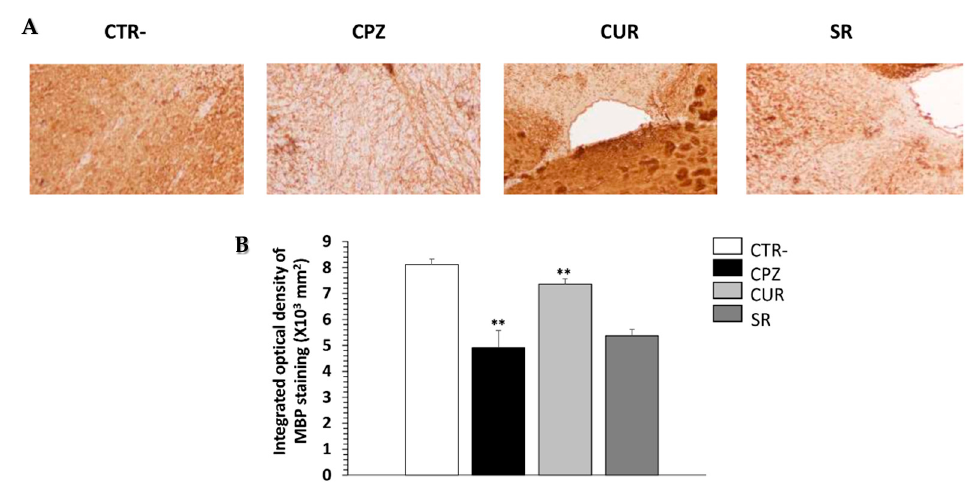
Figure 8. Effect of curcumin treatment on myelin content of corpus callosum during cuprizone intake. ( A ) Representative images for myelin basic protein (MBP) staining results (Obj × 20). ( B ) Quantitative analysis of MBP expression. n = 10 brain-sections from three mice, per experimental group. Negative group (CTR-), cuprizone-mice (CPZ) group, post-treated with curcumin (CUR) group and spontaneous remyelination mice (SR). Values are given as mean ± SEM as the results of ordinary one-way ANOVA followed by Tukey’s multiple comparison test; ** p < 0.01.